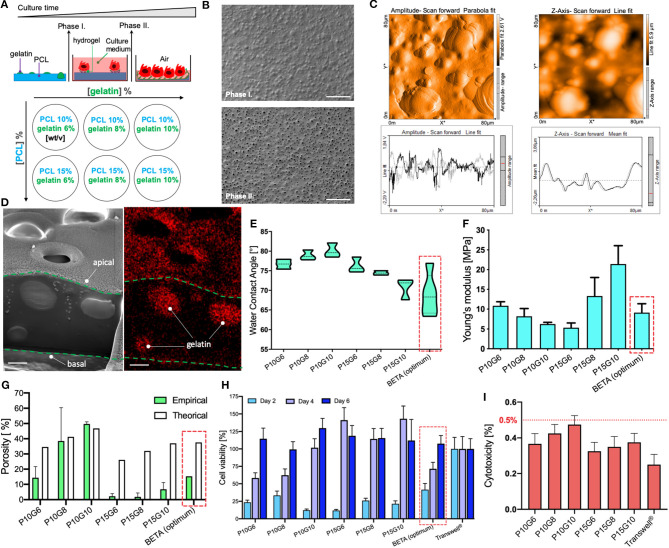
Characterization of the biphasic (BETA) membrane used in this study. (A) Schematic depiction of the biphasic membrane concept. (Top) During phase I, gelatin forms a hydrogel due to contact with water (cell culture medium), which serves as adhesion point for epithelial cells of the lung and facilitates subsequent cell proliferation until a confluent epithelial cell layer is formed. After 4 days (phase II), the gelatin has been dissolved in water leaving behind a network of interconnected pores in the PCL membrane, which provides space for further cell spreading and at the same time enhances both membrane permeability and elastic modulus. (Bottom) Different membranes with various combinations of mixing ratio of PCL and gelatin—in the PCL/gelatin solution used for membrane manufacturing—expected to obtain a wide range of physicomechanical properties. (B) Top view of the ultrastructure of the “optimum” membrane (9.35% PCL and 6.34% gelatin [w/v of TFE], i.e., P/G = 9.35/6.34), which is also used for the analysis presented in (C,D). The scale bar is 100 μm. (C) Surface topography of an 80 × 80 μm2 section of the membrane analyzed by Atomic Force Microscopy (AFM; left) and its corresponding z-amplitude profile (right) showing an average roughness height of 1.31 μm. (D) Cross-sectional analysis of the membrane using Focused Ion Beam-Scanning Electron Microscopy (FIB-SEM, left panel) and Energy Dispersive X-ray Spectroscopy FIB-SEM (EDS-FIB-SEM, right panel), indicating that gelatin is distributed throughout the PCL membrane during the late stage of phase I. The thickness of the membrane thickness ca. 5 μm. The scale bar is 2 μm. The newly manufactured membranes (P15G6, P15G8, and P15G10) are analyzed (and compared to previously reported results (Doryab et al., 2020) with respect to (E) Water Contact Angle (WCA), (F) Young's modulus (uniaxial, phase I, under dry conditions), (G) porosity obtained empirically by the liquid displacement method—and theoretical (maximum) porosity (gelatin volume fraction), (H) cell viability analyzed by WST1 assay on days 2, 4, and 6 of culture relative to PET Transwell® cell culture insert (H), and (I) cytotoxicity (LDH assay at day 6) of the three newly investigated membranes with different mixing ratios of PCL and gelatin. The LDH release for each membrane was normalized by the maximum possible LDH level (LDH contained in all cells). Typically, LDH < 10% is considered non-cytotoxic. There is no significant difference between the LDH release of Transwell® inserts and the different mixing ratios of BETA membranes. Optimum values for WCA, Young's modulus, empirical porosity, and theoretical (maximum) porosity were 69 ± 5 [°], 9.0 ± 1.9 [MPa], 15.32 [%] and 37.6 [%], respectively. Data are reported as the mean ± SD, n = 3.